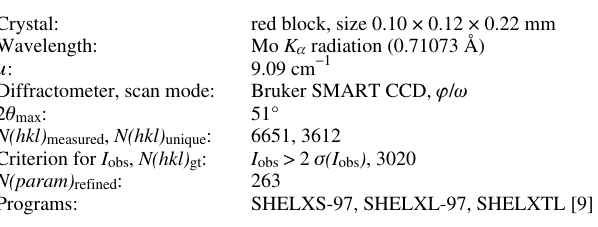
Table 1. Data collection and